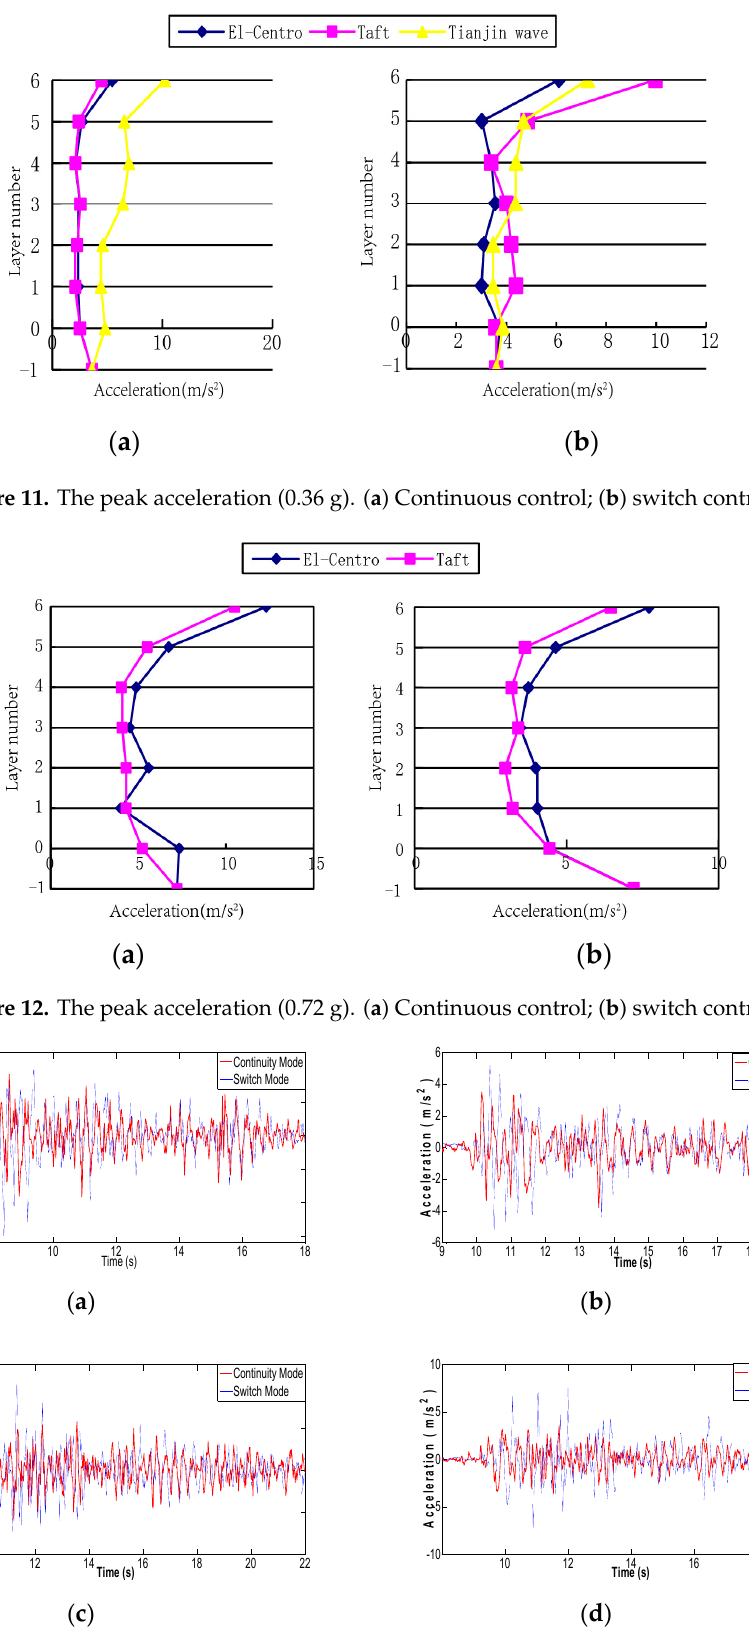
Figure 13. The displacement response of isolation layer. ( a ) El Centro earthquake—0.36 g; ( b ) El Centro earthquake—0.72 g; ( c ) Taft earthquake—0.36 g; ( d ) Taft earthquake—0.72 g.